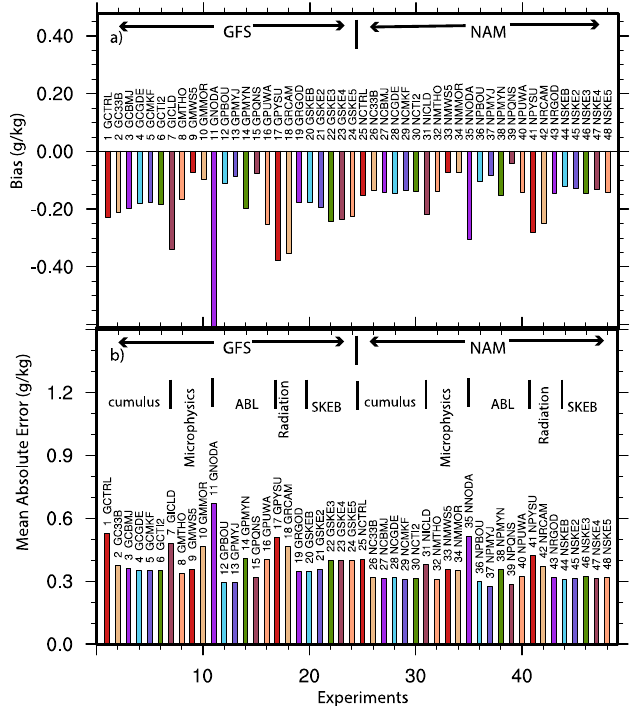
Figure 8. Averages on Domain 3 of ( a ) bias and ( b ) MAE in Q2 from analyses during the one-week study period in January. The unit is g/kg.